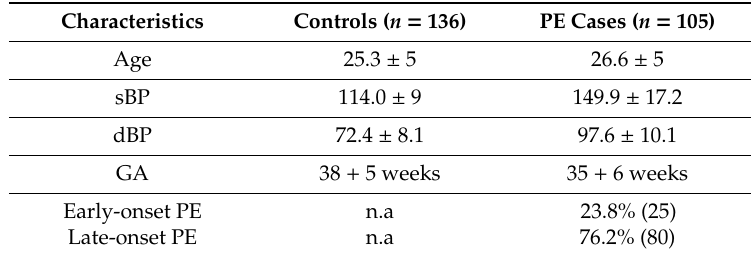
Table 1. Demographic and clinical characteristics of study